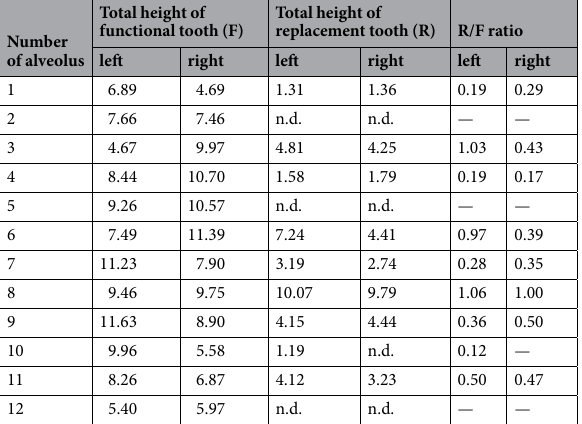
Table 6. Tooth height and the R/F ratio in the lower jaw of IVPP V12633. n.d. = not developed. All measurements in